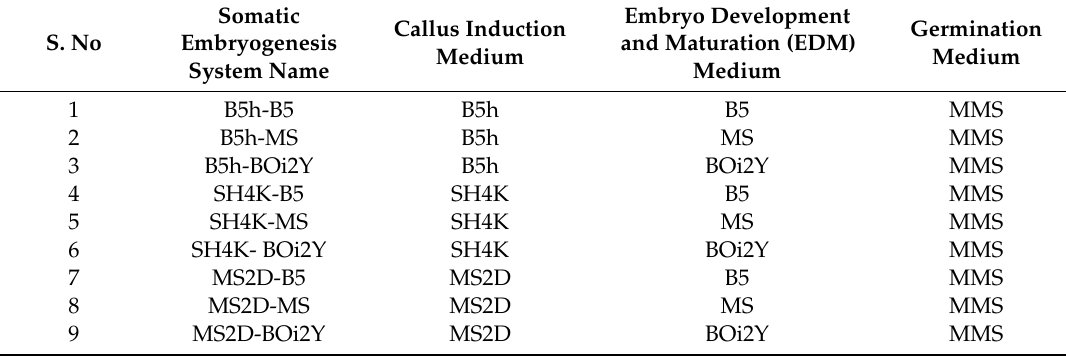
Table 2. Various somatic embryogenesis systems studied with their medium name for di ff erent phases.